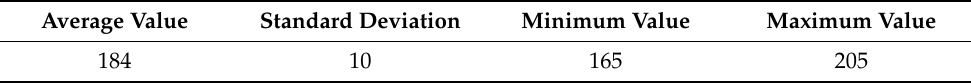
Table 4. The characteristics of the distance distribution between standard templates. Average